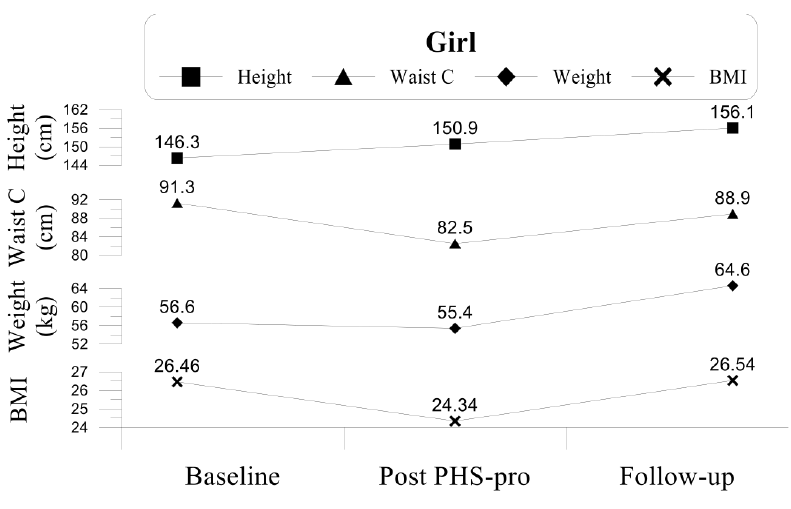
Figure 1. Anthropometric data of the boy.